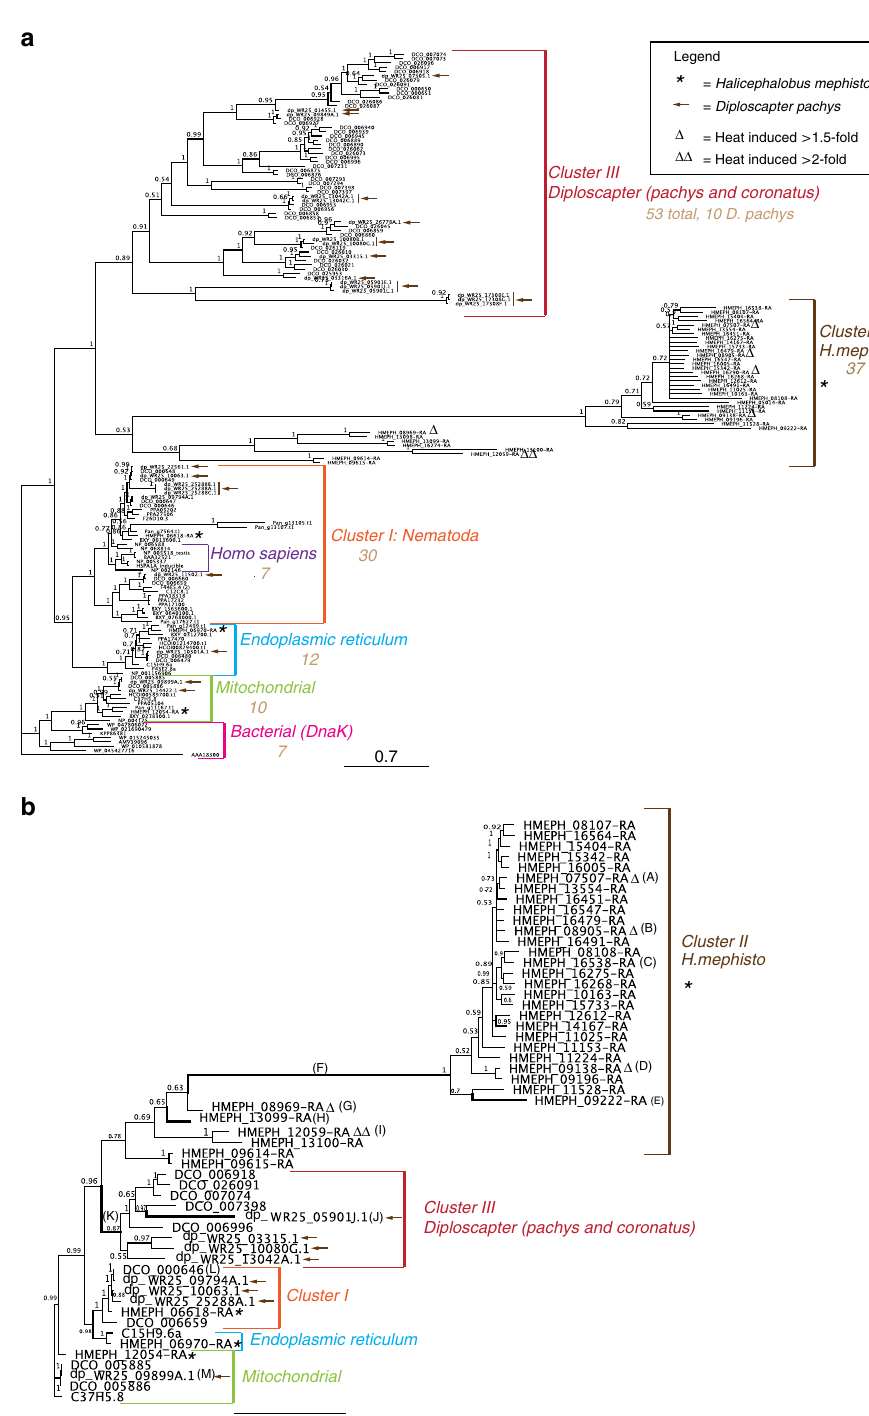
Fig. 2 Analysis of Hsp70. a Bayesian phylogenetic tree of Hsp70. H. mephisto sequences marked with an asterisk (*) and D. pachys with arrows. Branch numbers indicate posterior probabilities; scale bar represents substitutions per site. b Hsp70 protein Bayesian tree used for dN/dS analysis of coding sequence. Branch letters A – M correspond to Table 3 for ω (dN/dS) value. Bold branches indicate statistical signi fi cance of dN/dS p value after